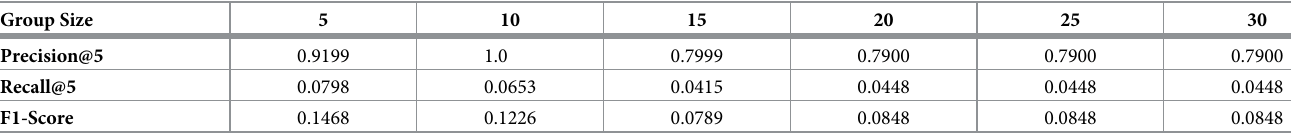
Table 15. Performance of HTGF by varying group size.